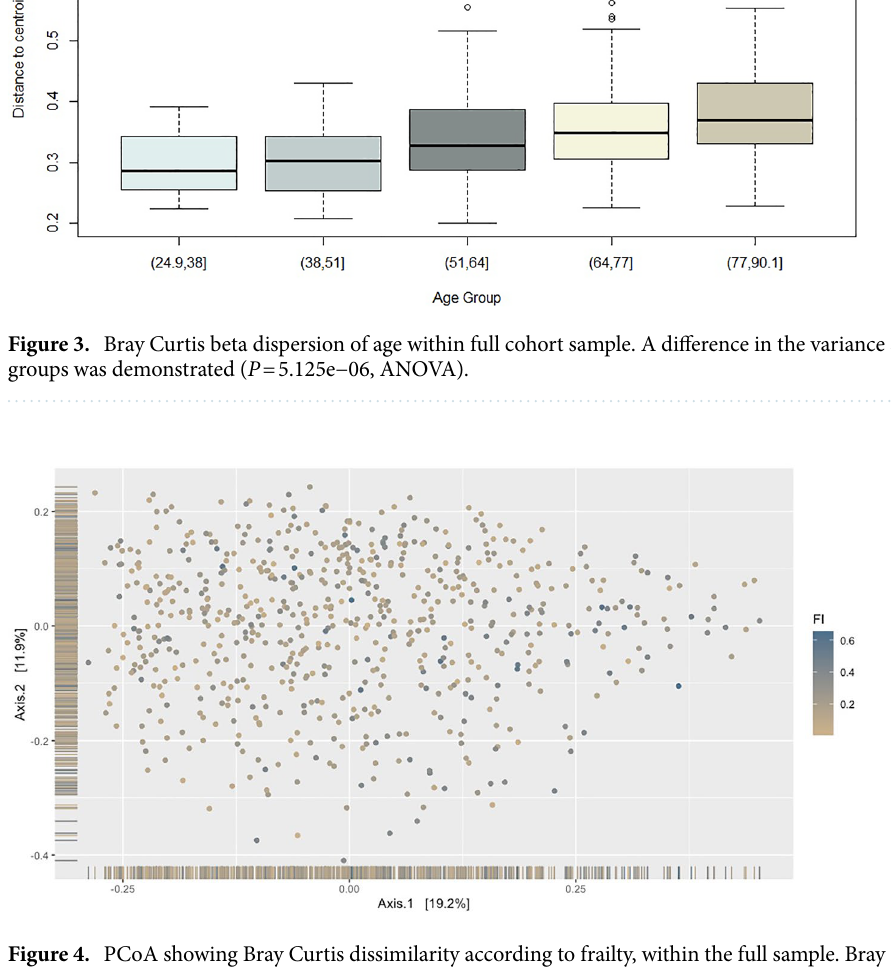
Figure 4. PCoA showing Bray Curtis dissimilarity according to frailty, within the full sample. Bray Curtis dissimilarity was associated with frailty index (FI), Q = 0.002, PERMANOVA. Each sample is assigned colour gradient reflecting low (brown) to higher (blue) frailty